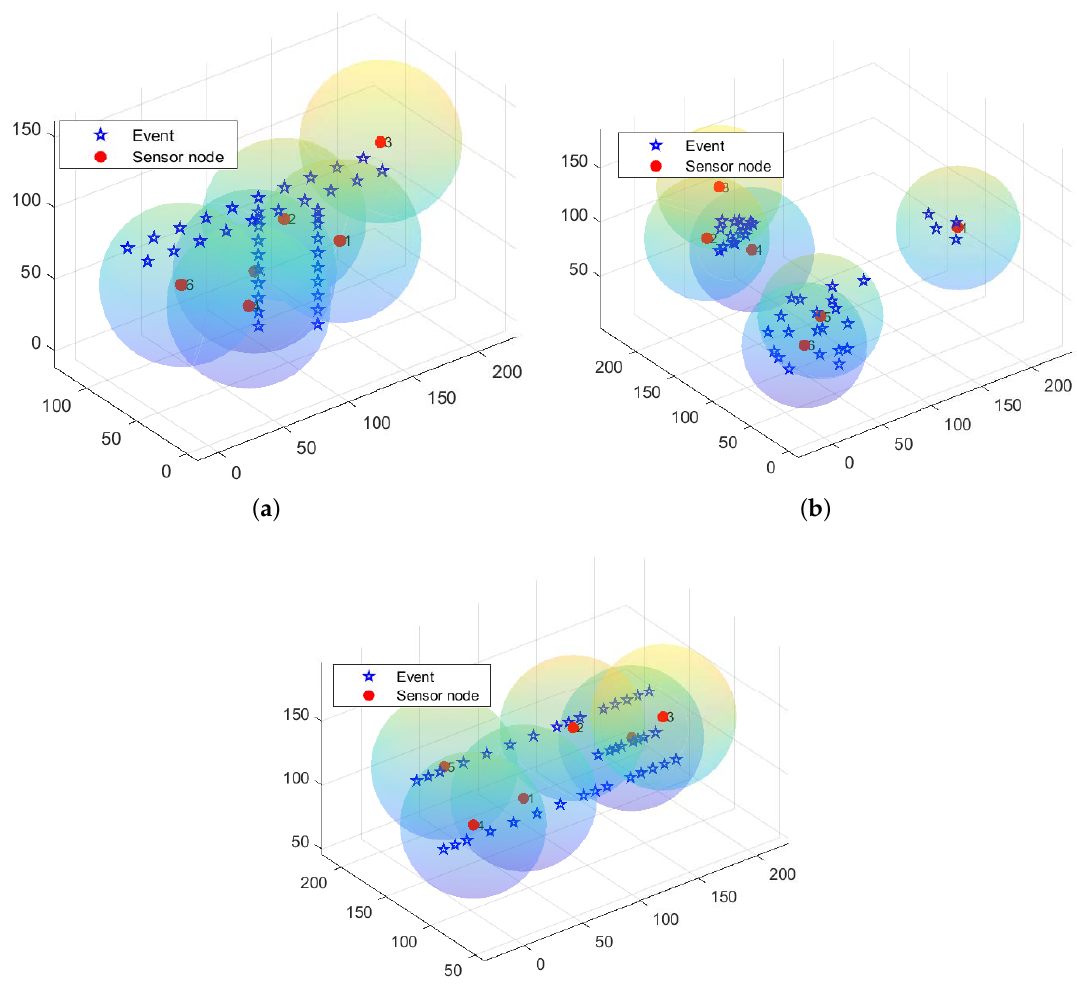
Figure 6. Achievement of self-organized Deployment of Nodes using the DHFSOA. ( a ) events unevenly distributed in a T shape; ( b ) 40 events randomly distributed; ( c ) 40 events unevenly distributed linearly.